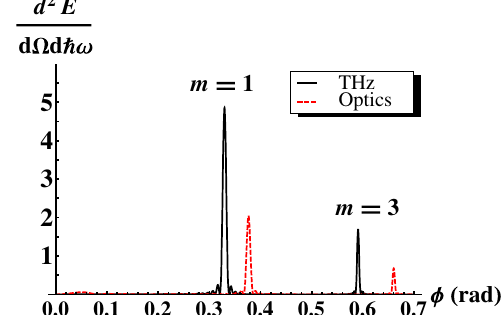
FIG. 7. The distribution of SPR over the conical surface, i.e., at θ ¼ arccos ð β − 1 sin α Þ . Red dashed curve is the distribution for the optical frequency region. It is plotted using Eq. (35) for γ ¼ 1710 (electron energy of Mainz Microtron MAMI: E ¼ 855 MeV), d ¼ 9 μ m, λ ¼ 546 nm, h ¼ 127 μ m. The black curve is the distribution for the THz frequencies, plotted using Eq. (35) for γ ¼ 13 , d ¼ 10 mm, λ ¼ 0 . 5 mm, h ¼ 0 . 5 mm. For both curves N ¼ 20 , α ¼ π = 6 , a ¼ d= 2